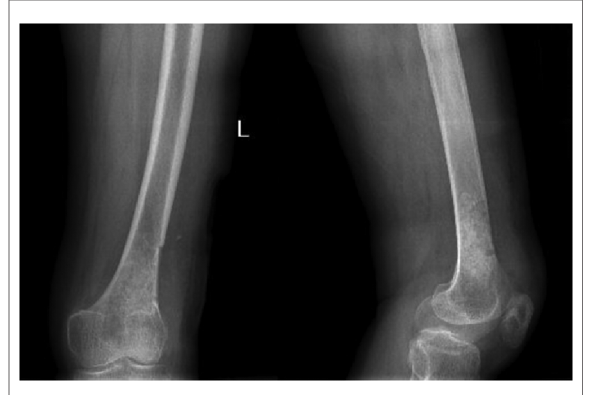
FIGURE 5 Anteroposterior and lateral radiographs of the left femur showing no abnormal signal at the left distal femur on the 3rd day after the surgery.